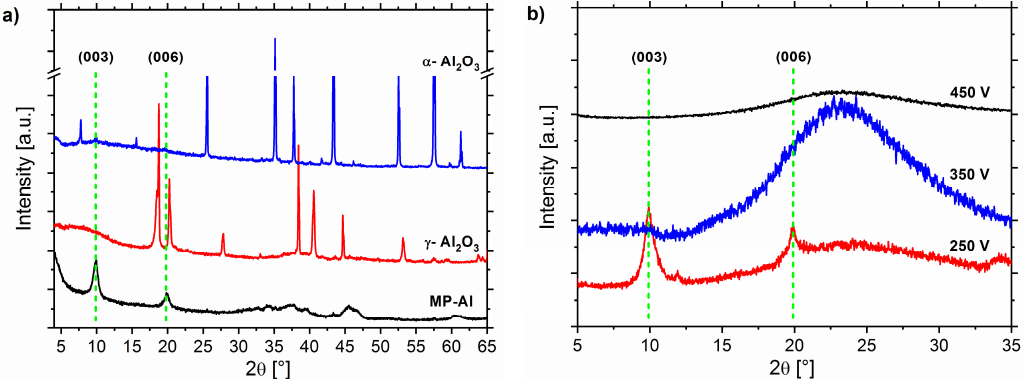
availability for the LDH growth. 4